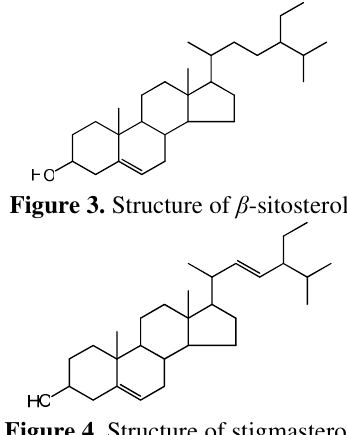
Figure 4. Structure of